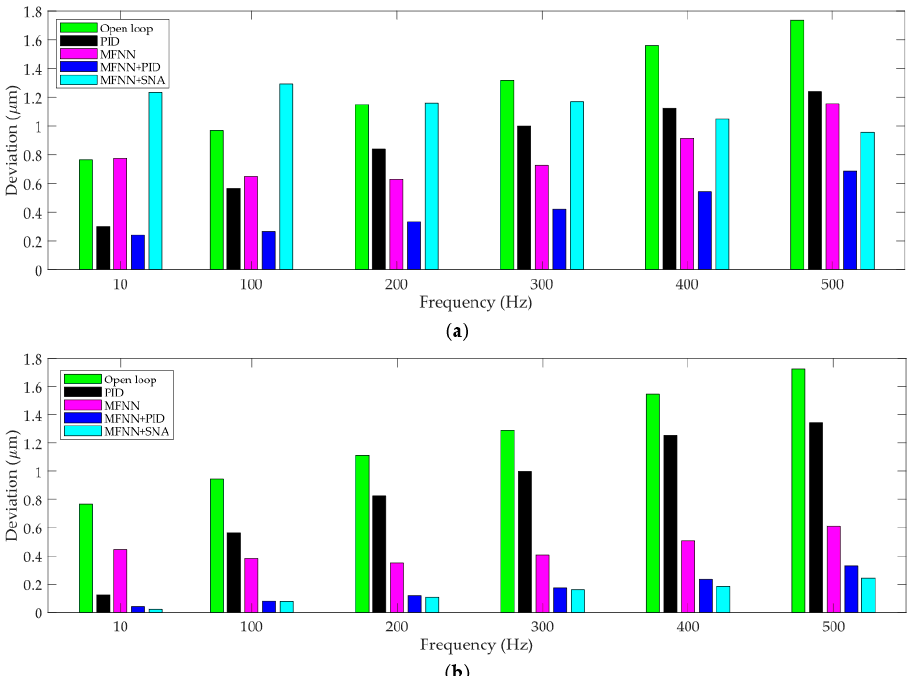
Figure 9. The maximum deviations of the PEA using different controllers: ( a ) in the transient and ( b ) in the steady state.